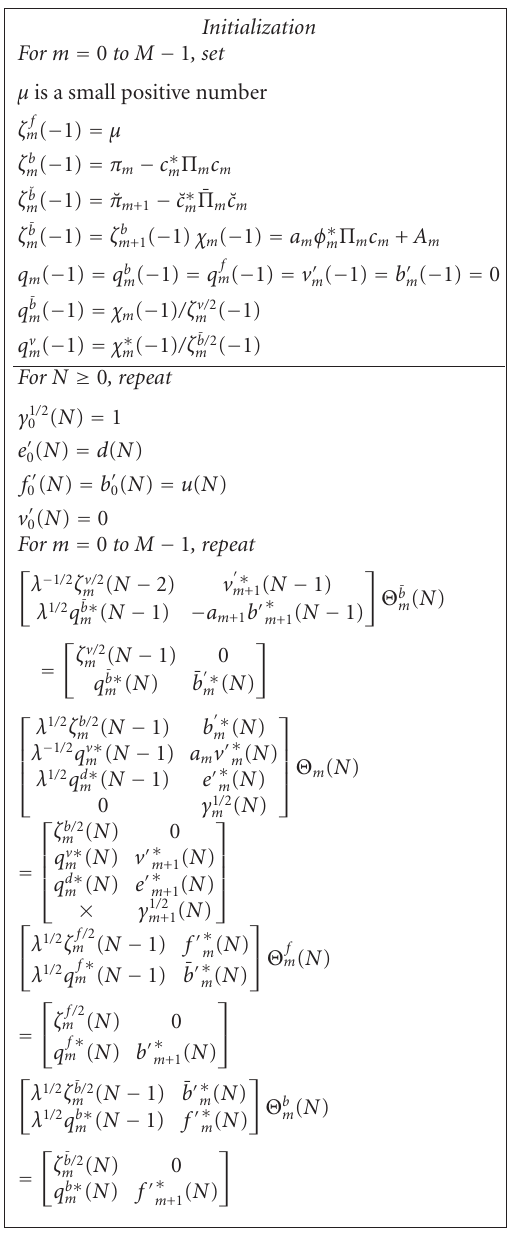
Algorithm 5: The array-based extended RLS lattice